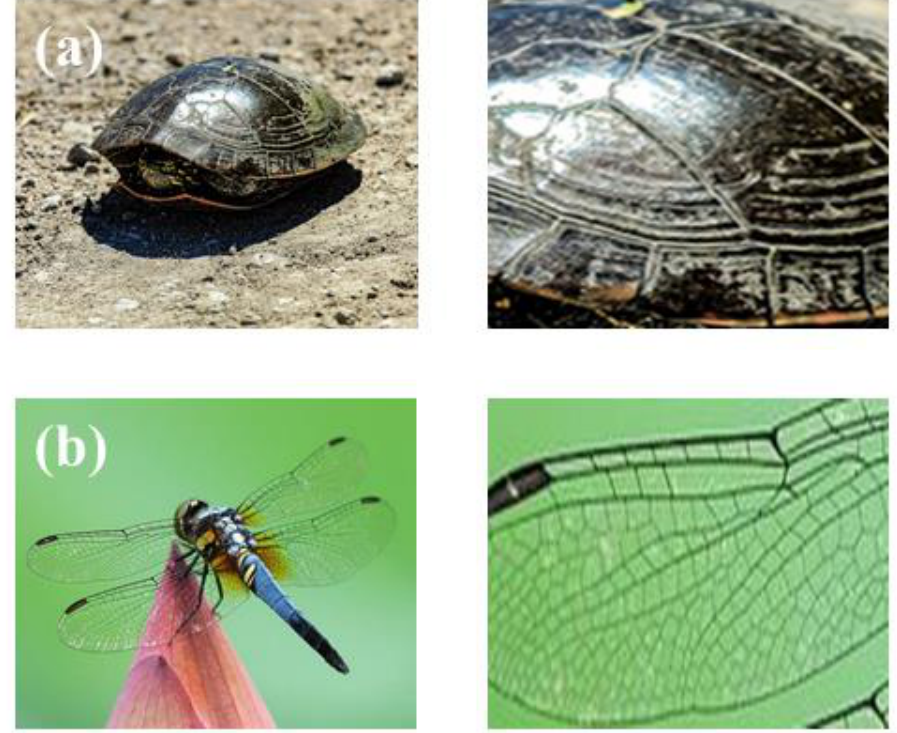
Figure 1. Biomimetic structures in living organisms and their partial magnifications: ( a ) turtle; ( b ) dragonfly.